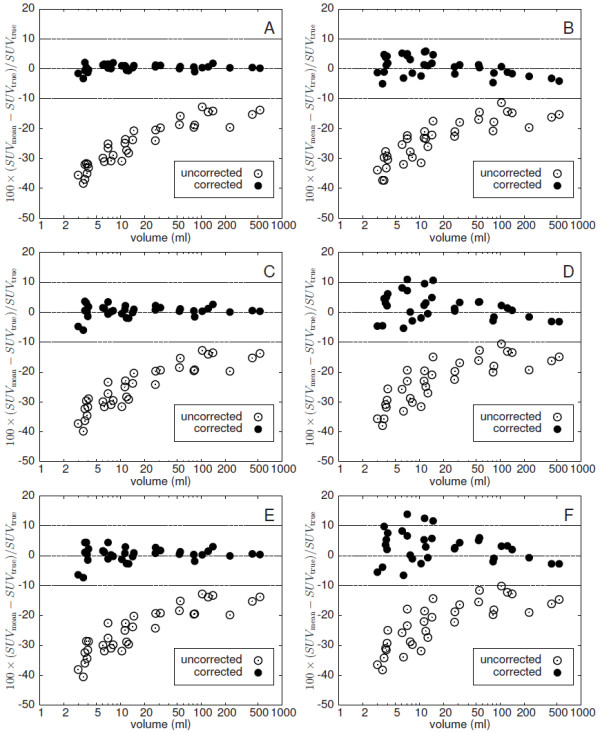
Difference between LBPVC-corrected and true SUVmeanat additional noise levels with a FWHM of the Gaussian noise of 3.5% (A, B), 7.1% (C, D) and 10% (E, F), respectively. Left column: without automatic ROI delineation (true lesion boundary is used). Right column: with automatic ROI delineation. Note the logarithmic scale of the abscissa